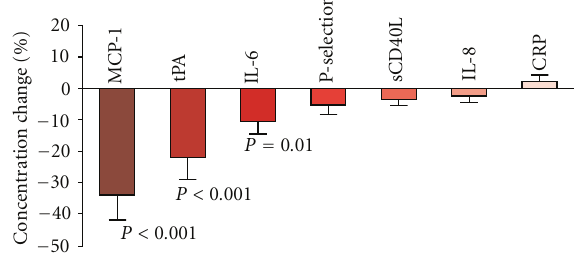
Figure 1: Changes in plasma concentrations of inflammatory markers after two years of followup. The observed decreases in plasma concentrations of inflammatory biomarkers (expressed as percentages) were only significant for MCP-1, tPA, and